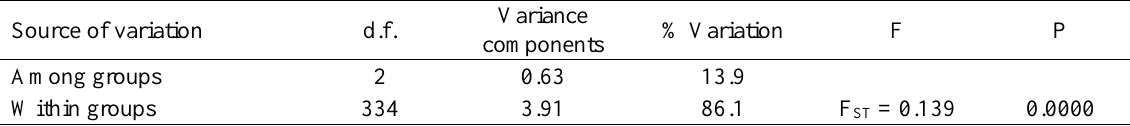
Table A2.5. Analysis of molecular variance (AMOVA) based on mtDNA haplotype data for the three groups identified by structure analysis. F ST represents the variance within groups relative to the total